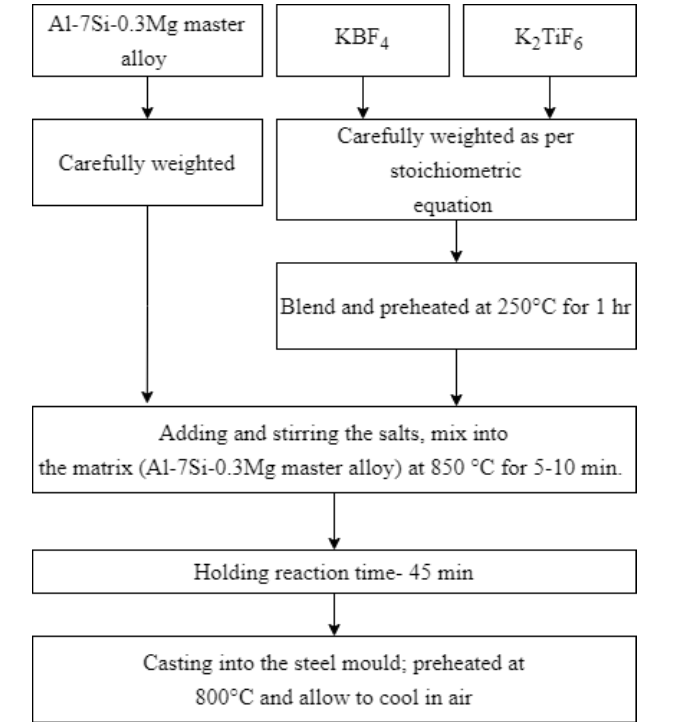
Fig. 1. Flow process chart of the in situ process used for synthesizing Al-7Si- 0.3Mg/TiB 2